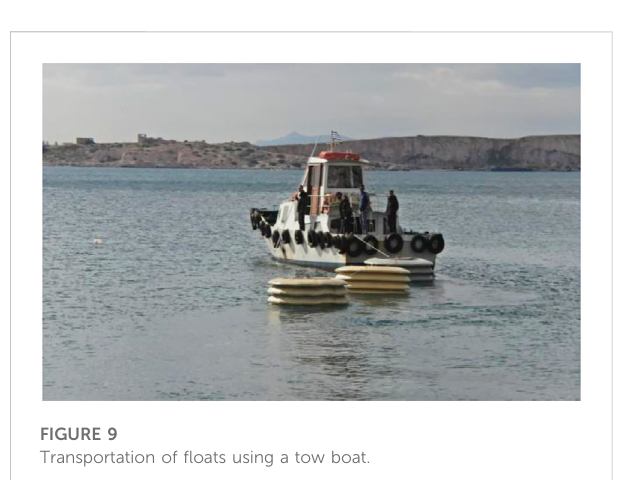
FIGURE 9 Transportation of fl oats using a tow boat.